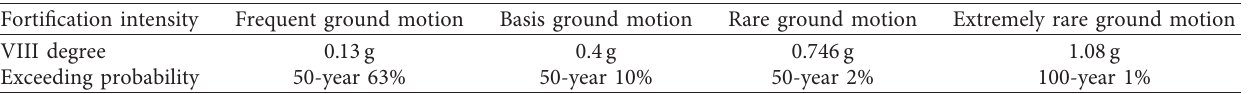
Figure 7: The ground motions selected from the PEER. (a) The distribution relationship between PGA and the epicentral distance of selected seismic. (b) The response spectrum of near-fault pulsed ground motions. (c) The response spectrum of far-field ground motions. Table 4: Calculation scheme of controlling variable method of different interface